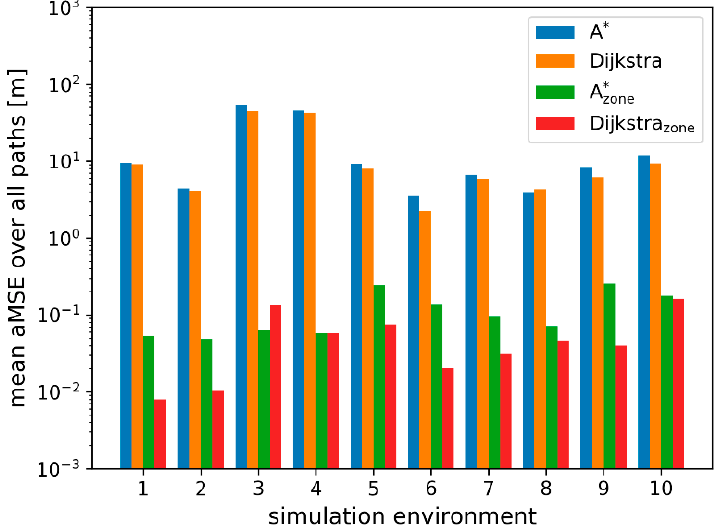
Figure 11. Average mean square error over all paths for each simulated environment.